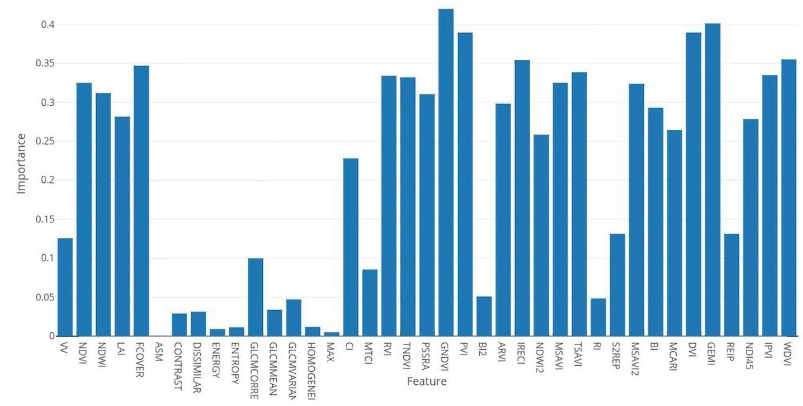
Figure 3. Importance of all extracted